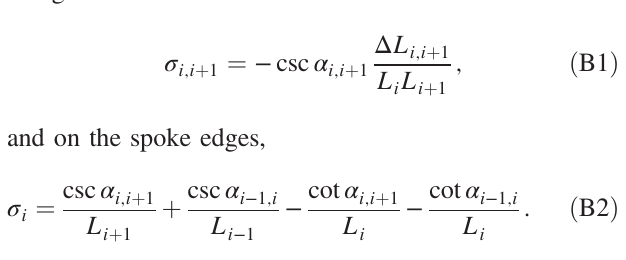
FIG. 12. Trigonometric diagram for verification of force bal- ance at spoke vertex i along the direction parallel to the spoke. The “ crossed ladder ” identity relates the lengths of the three parallel dashed lines, 1 =A þ 1 =B ¼ 1 =h